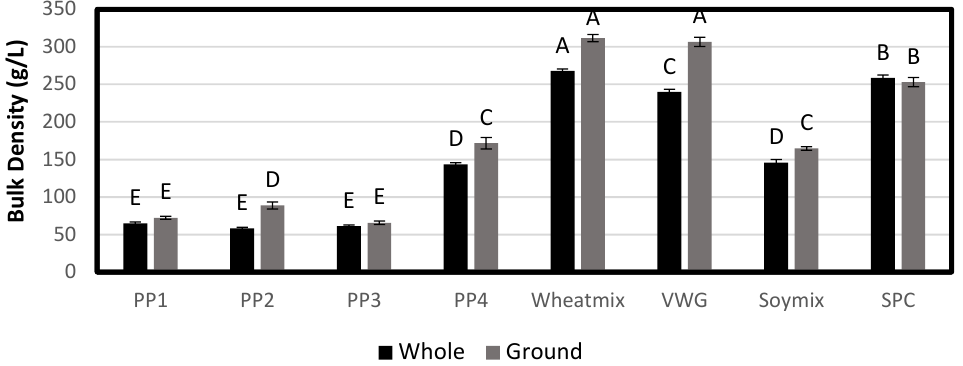
Figure 13. Average bulk density of whole extrudate and ground extrudate. Bars denoted by the same letter are not significantly different ( p < 0.05).